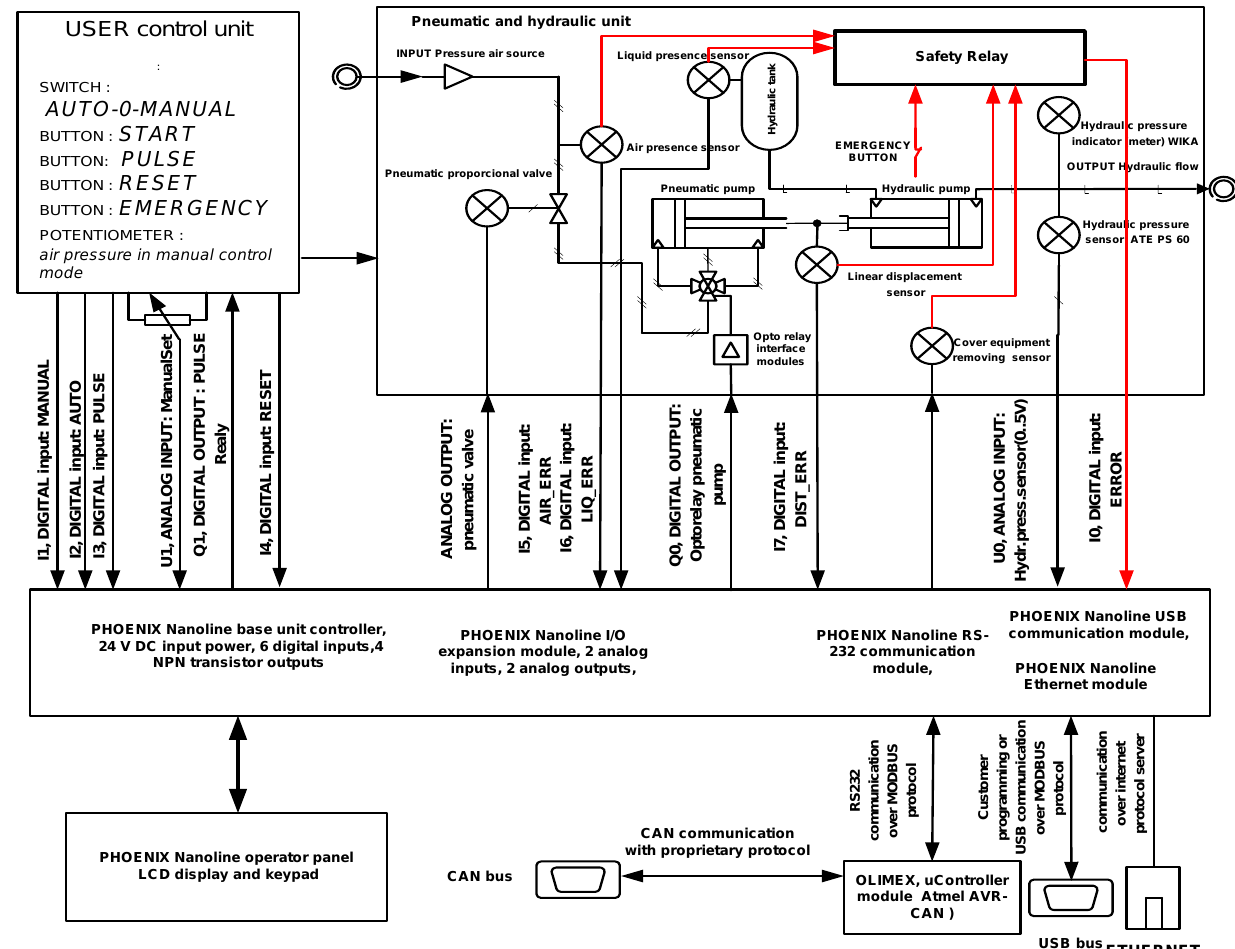
PHOENIX Nanoline operator panel LCD display and keypad